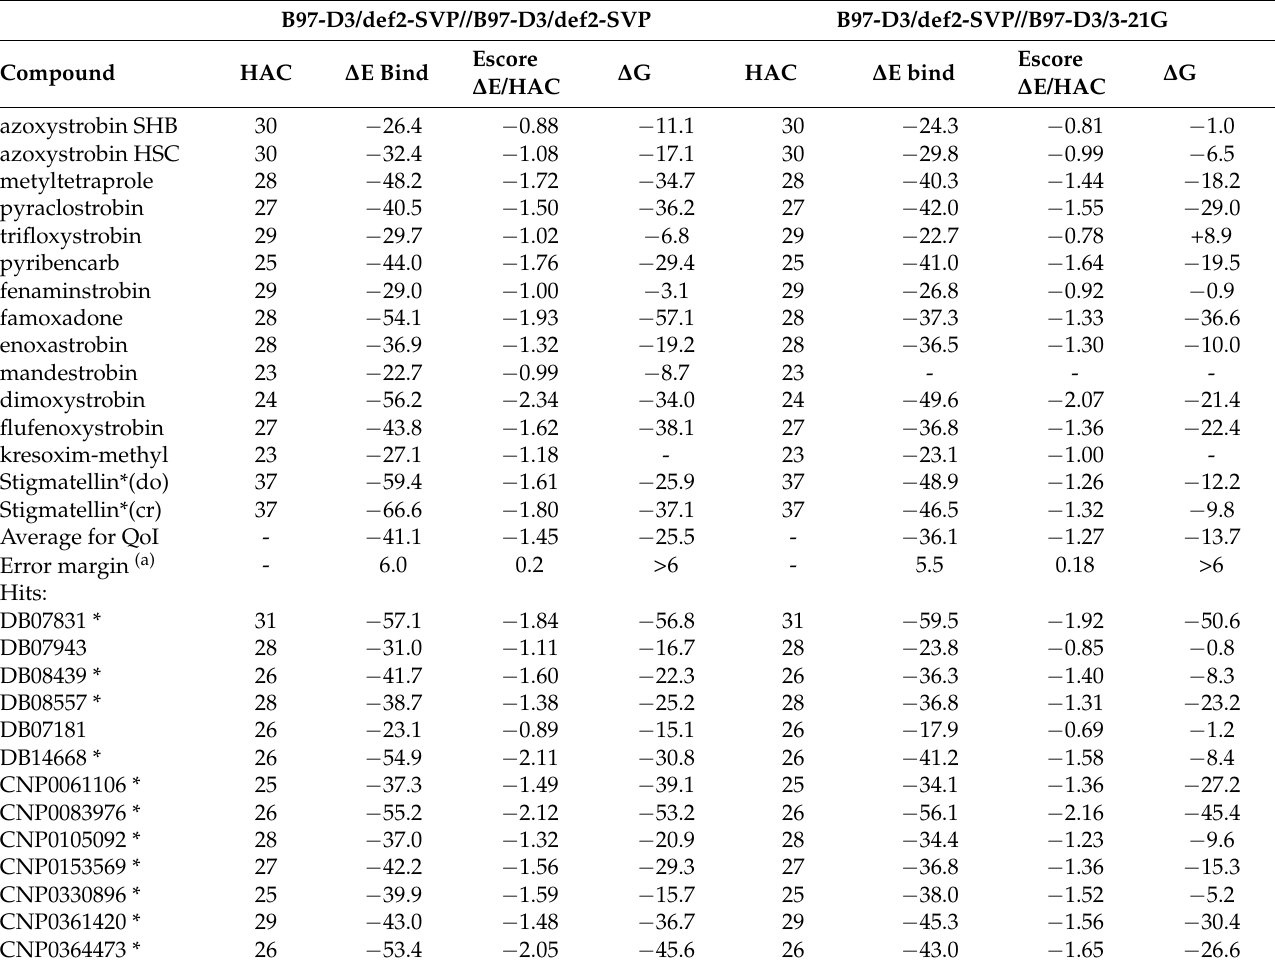
Table 4. QM/MM binding energy table. ∆ Ebind as electronic binding energy, Escore is the same scaled by heavy atom count (HAC), ∆ G is Gibbs-free binding energy with all enthalpy and entropy corrections to ∆ E bind. B97-D3/def2-SVP//B97-D3/def2-SVP